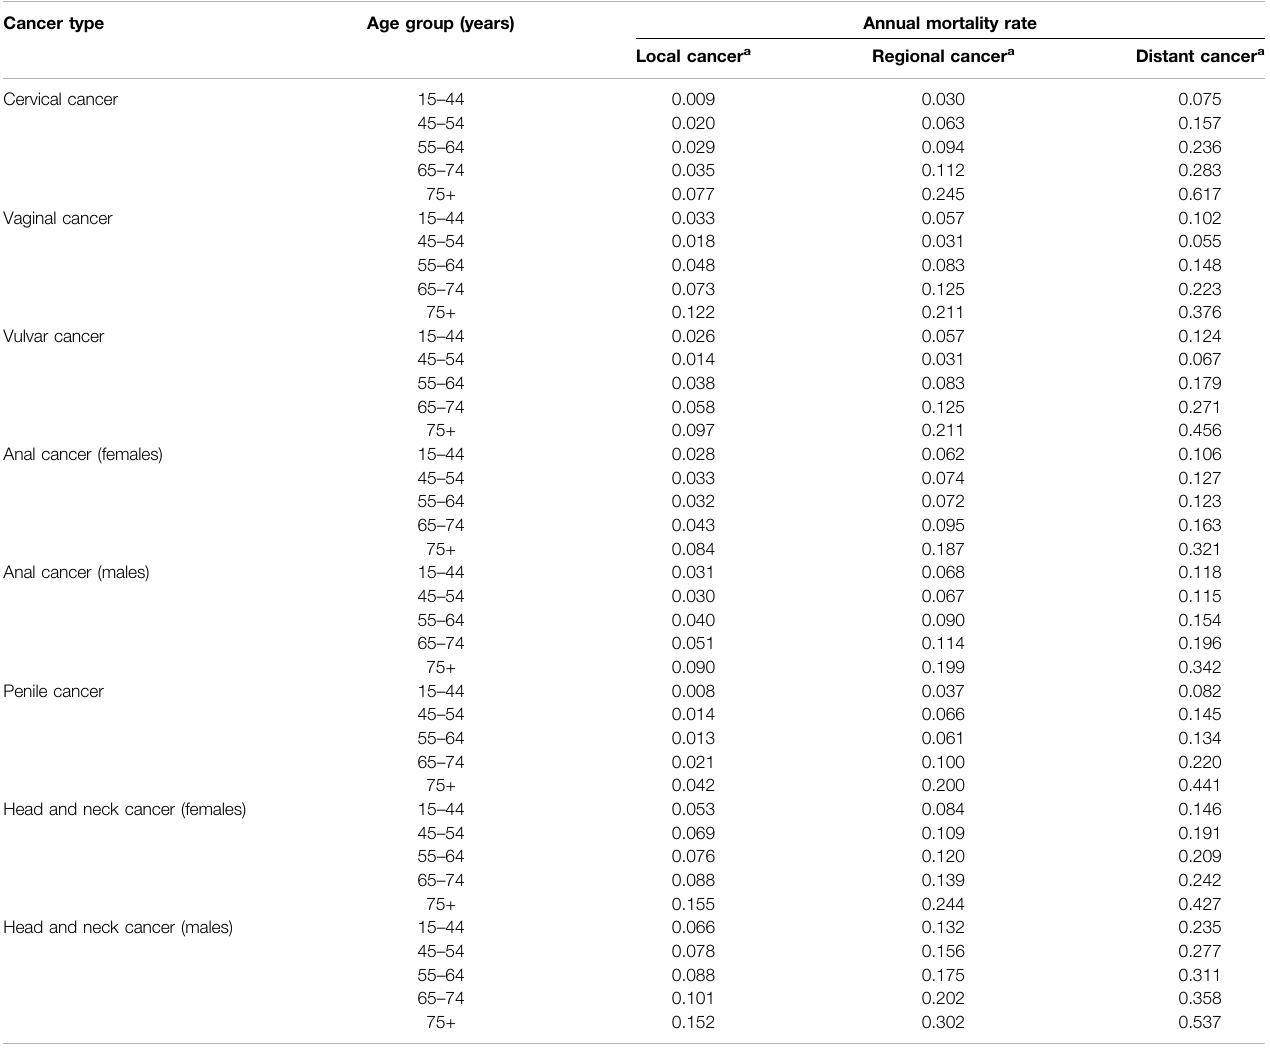
TABLE 1 | Summary table on cancer mortality. Cancer type